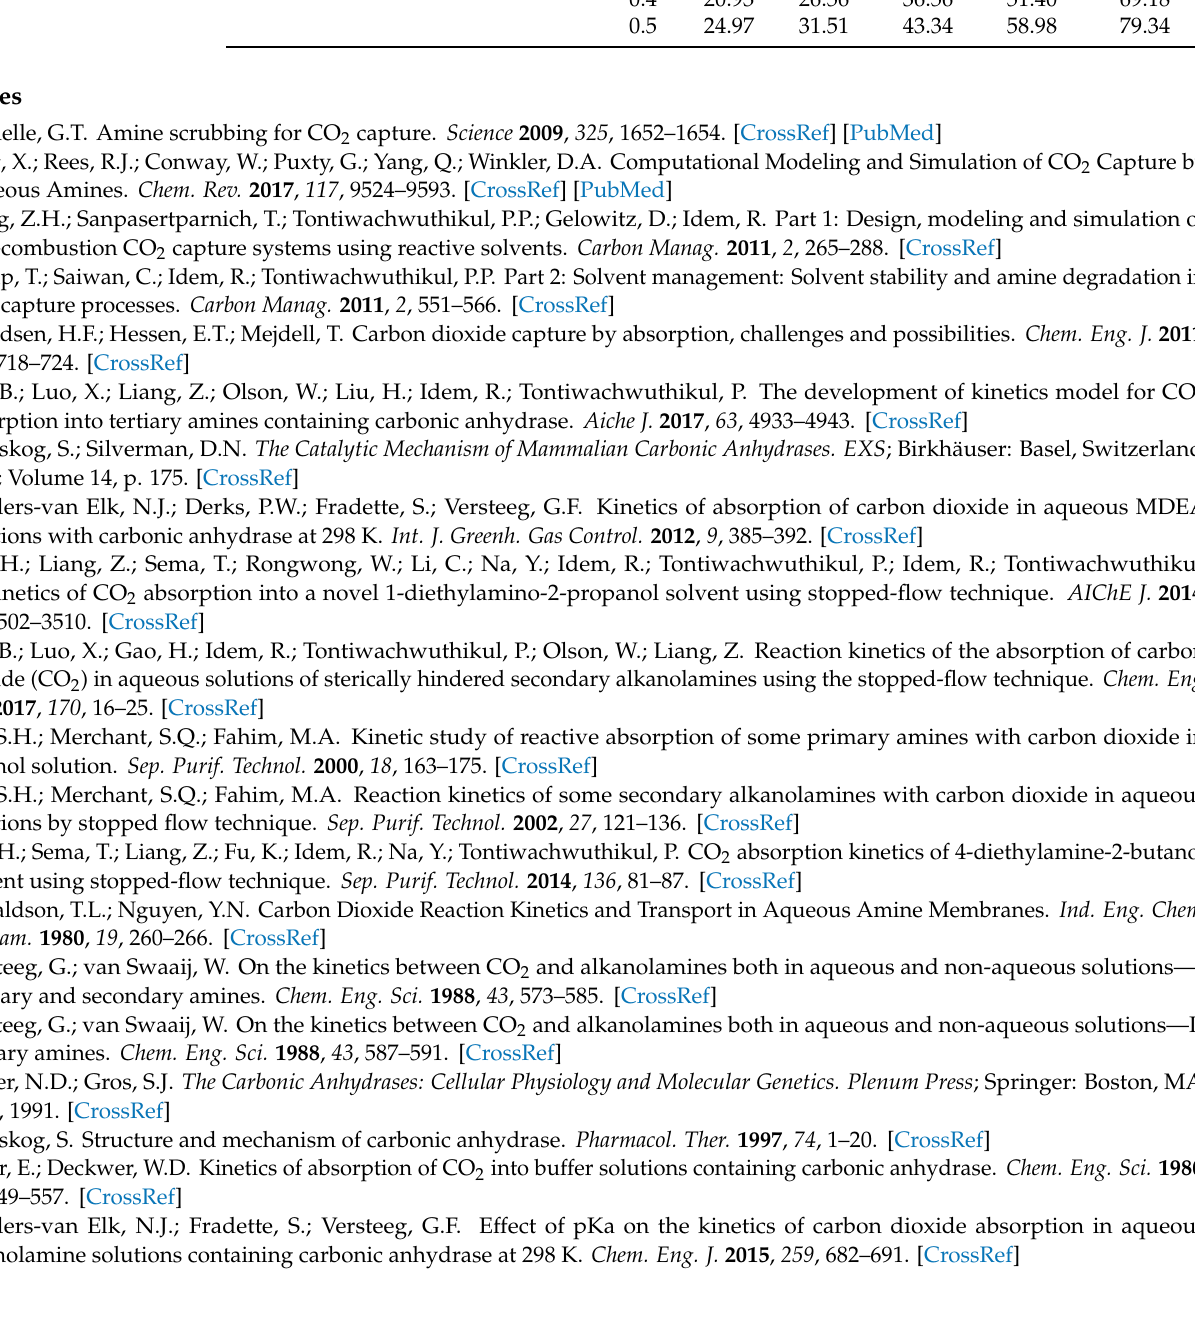
reacting with aqueous TEA and DEEA 2